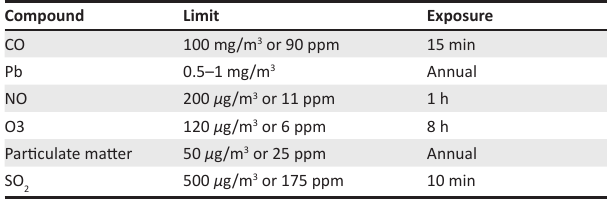
TABLE 5: Vehicle emission